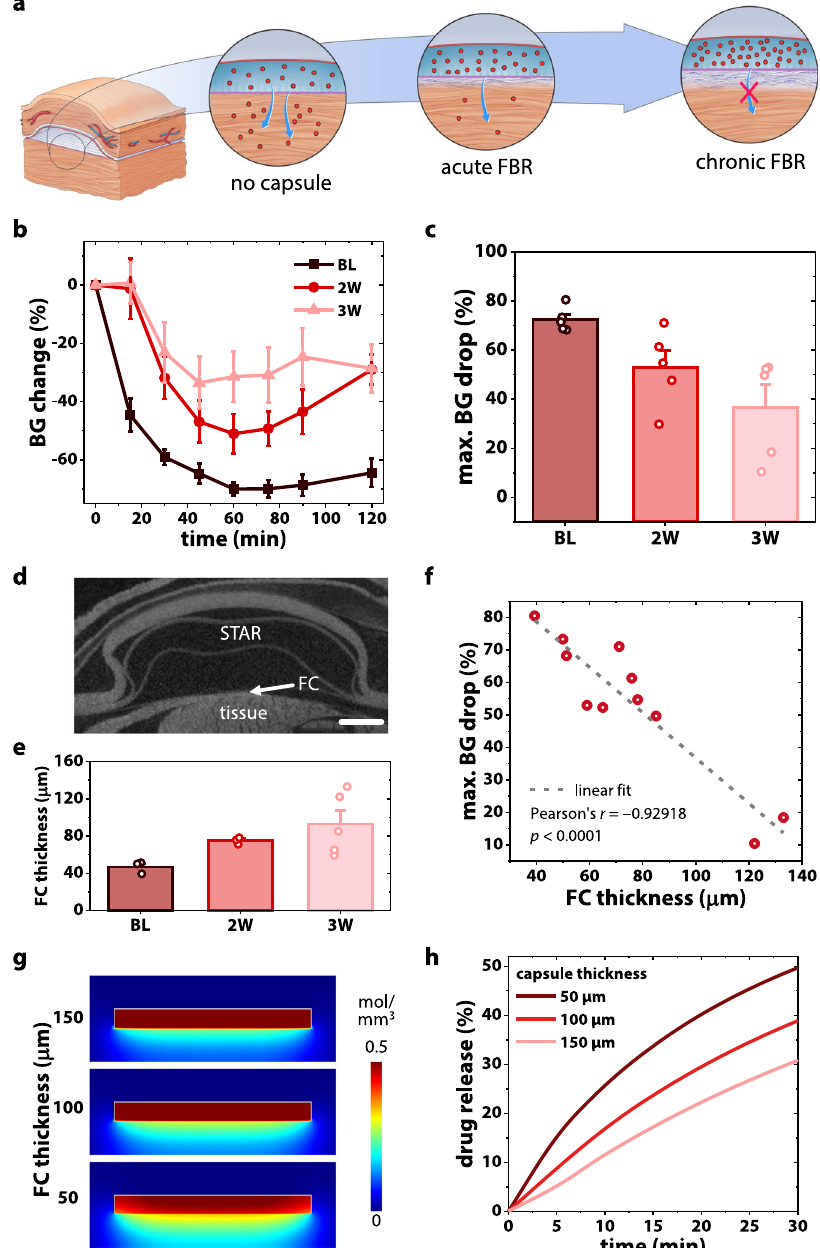
Fig. 2 | Development of a pre-clinical model to monitor the effect of FBR on therapy transport longitudinally. a Schematic demonstrating detrimental effect of fi brous capsule (FC) formation on therapy delivery with time. b Blood glucose (BG) response to human insulin delivered via STAR, measured over 120min at baseline (BL, day 3), week 2 and week 3. n =5 mice at each time point. c Temporal evolutionofthemaximumBG%drop(denotingfunctionaleffect),calculatedfrom b . d Representative 2D µ CT slice of STAR with fi brous encapsulation. Scale bar is